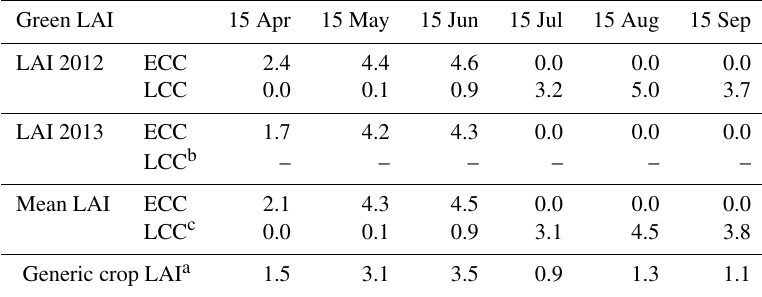
Table 3. LAI dynamics of early-covering crops (ECC) and late-covering crops (LCC) in 2012 and 2013 in the Kraichgau region, southwest Germany, as well as the LAI dynamics of the generic crop.